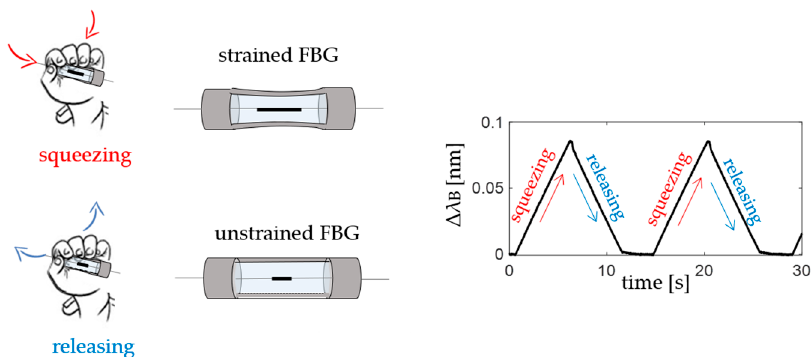
Figure 3. The smart graspable device (SGD) principle of working during grasping: squeezing (in red) and releasing (in blue) phases.